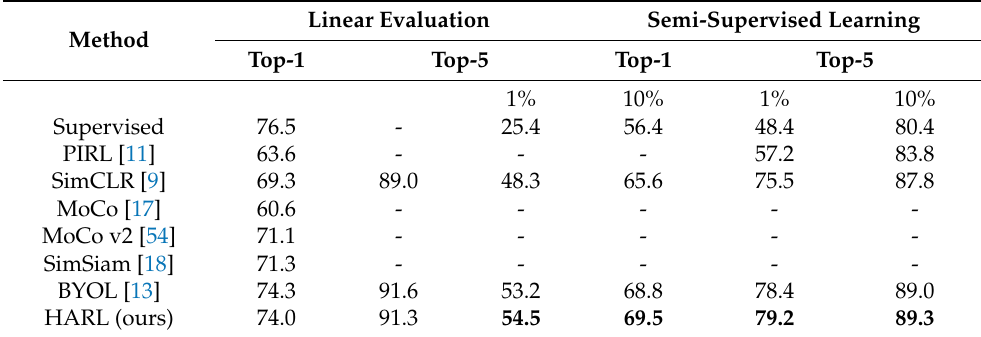
Table 1. Evaluation on the ImageNet. The linear evaluation and semi-supervised learning with a fraction (1% and 10%) on ImageNet labels report Top-1 and Top-5 accuracies (in%) using the pre-trained ResNet-50 backbone. The best result is